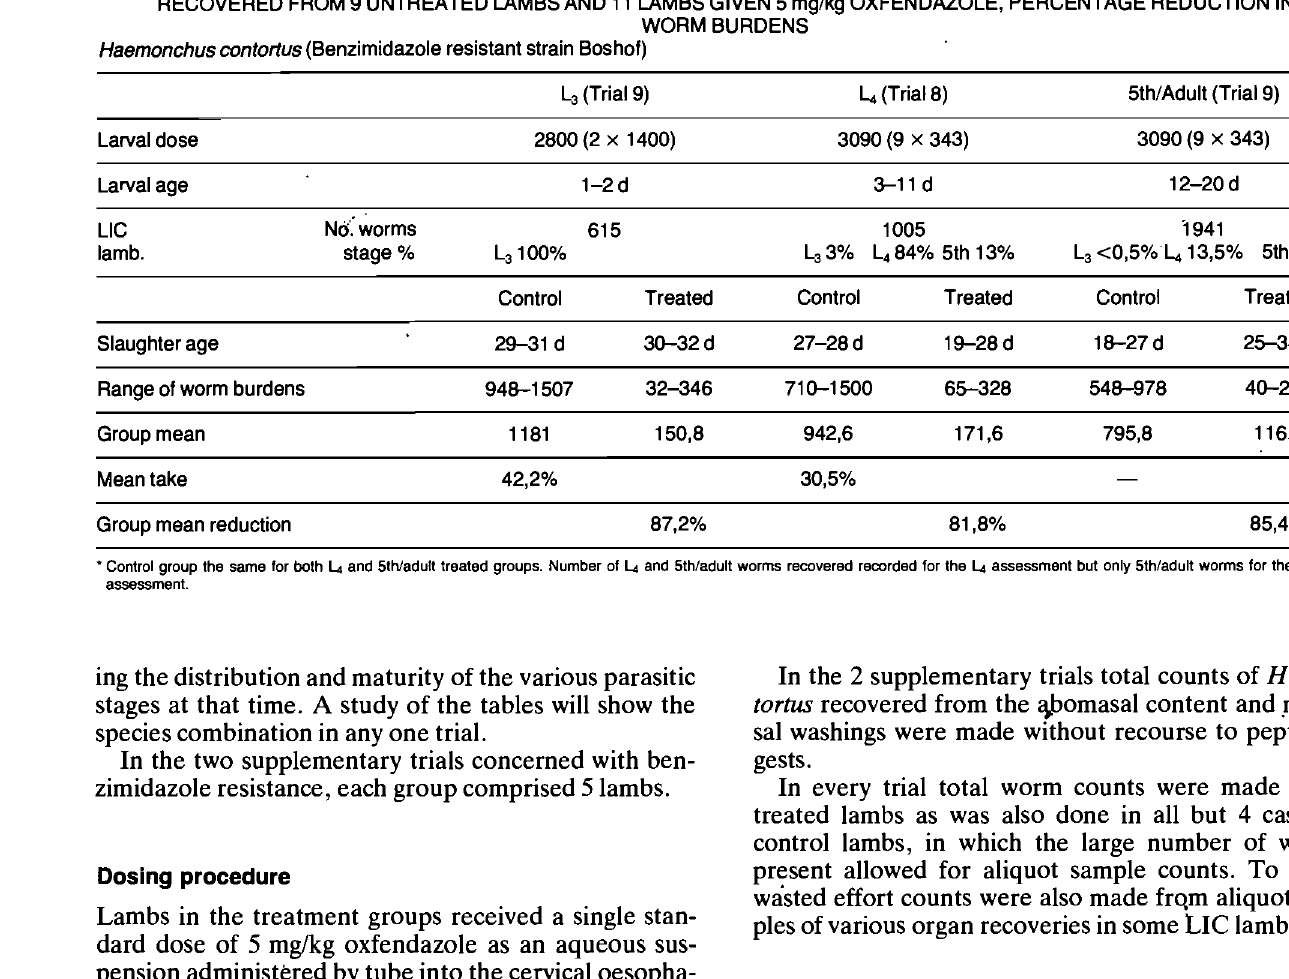
Table 3: LARVAL IN FECTION RATES, LARVAL AGES AT TIME OF TREATMENT AND SLAUGHTER, RANGE IN NUMBER OF WORMS RECOVERED FROM 9 UNTREATED LAMBS AND 11 LAMBS GIVEN 5 mg/kg OXFENDAZOLE, PERCENTAGE REDUCTION